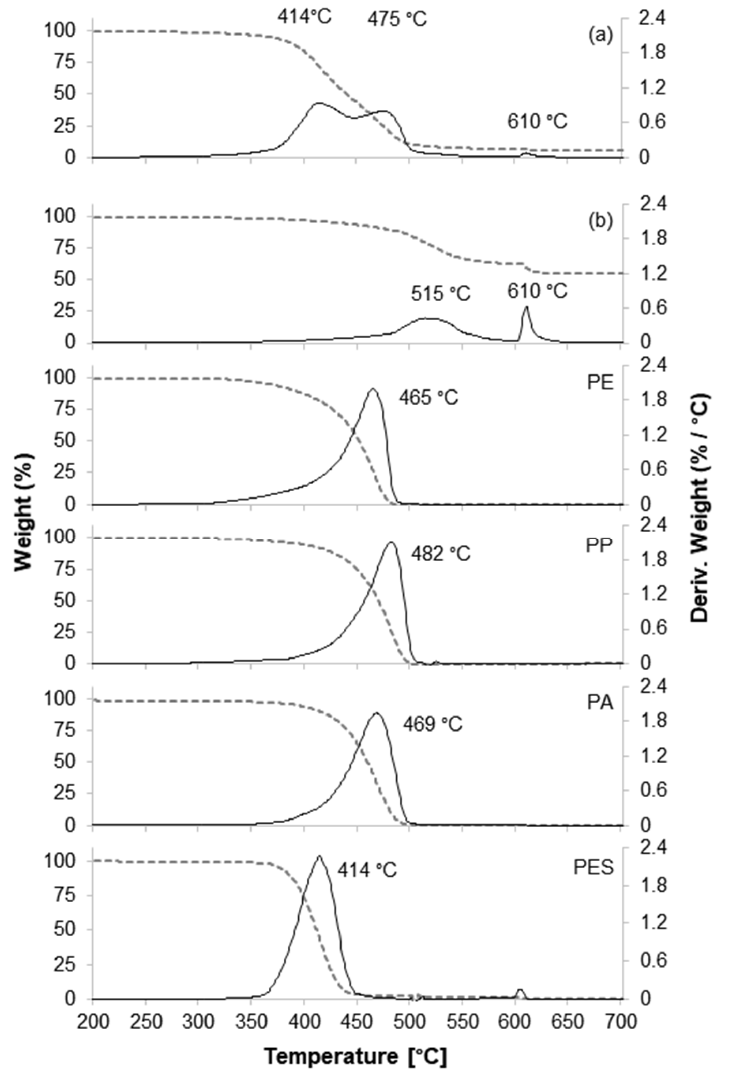
Figure 9. TGA curves of ( a ) agglomerate formed in removal process 100 mg of PE/PP/PA/PES (1:1:1:1) from 1 L demineralized water using 100 µL n-Butyltrichlorosilane; ( b ) hybrid silica formed by adding 100 µL n-Butyltrichlorosilane in 1 L demineralized water and different polymer types used in experiments. Grey dashed line = weight in %; black line = derived weight in %/°C.